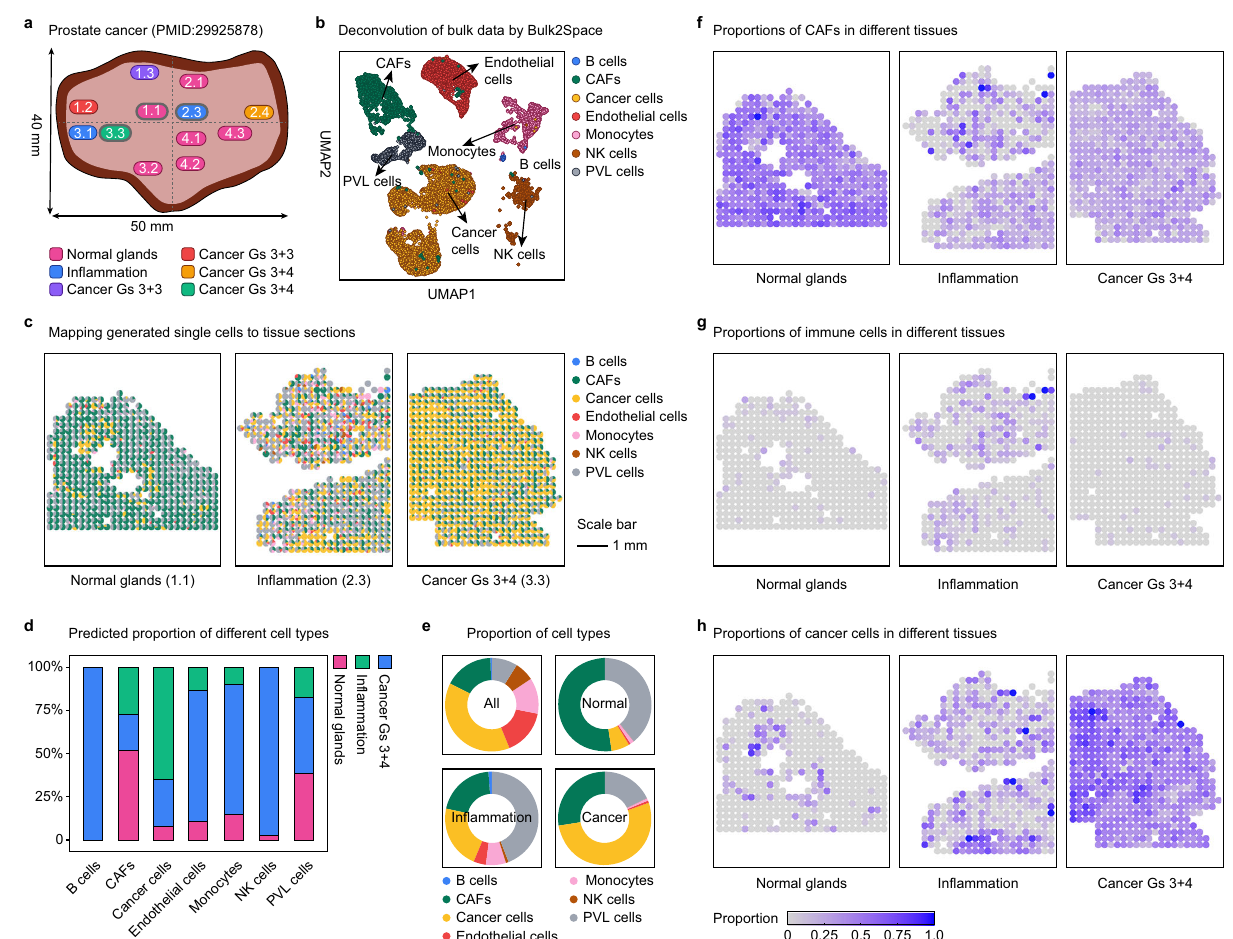
Fig. 6 | Spatial gene expression dynamics analysis of in fl ammation-induced prostate cancer by Bulk2Space.a Experimental design ofthe bulk transcriptome data.Thetissuewassegmentedintodistinctregions,namely,normalglands(pink), in fl ammation (blue), and several cancer regions (red, green, purple, and yellow). Three tissue regions (1.1 normal, 2.3 in fl ammation, and 3.3 cancer region) were isolated to conduct spatially resolved transcriptomics. b The t-SNE layout of the generated single-cell pro fi les by Bulk2Space. Each cell type was represented by a unique color. c The proportions of generated single cells that were mapped to normal,in fl ammation, and cancer region byBulk2Space, respectively. The color of